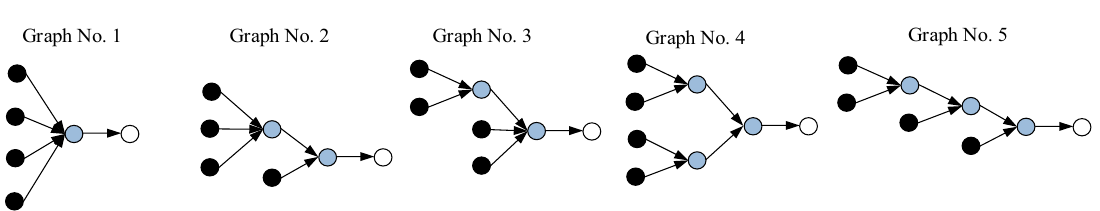
Figure 1. All possible alternative assembly line structures with four input